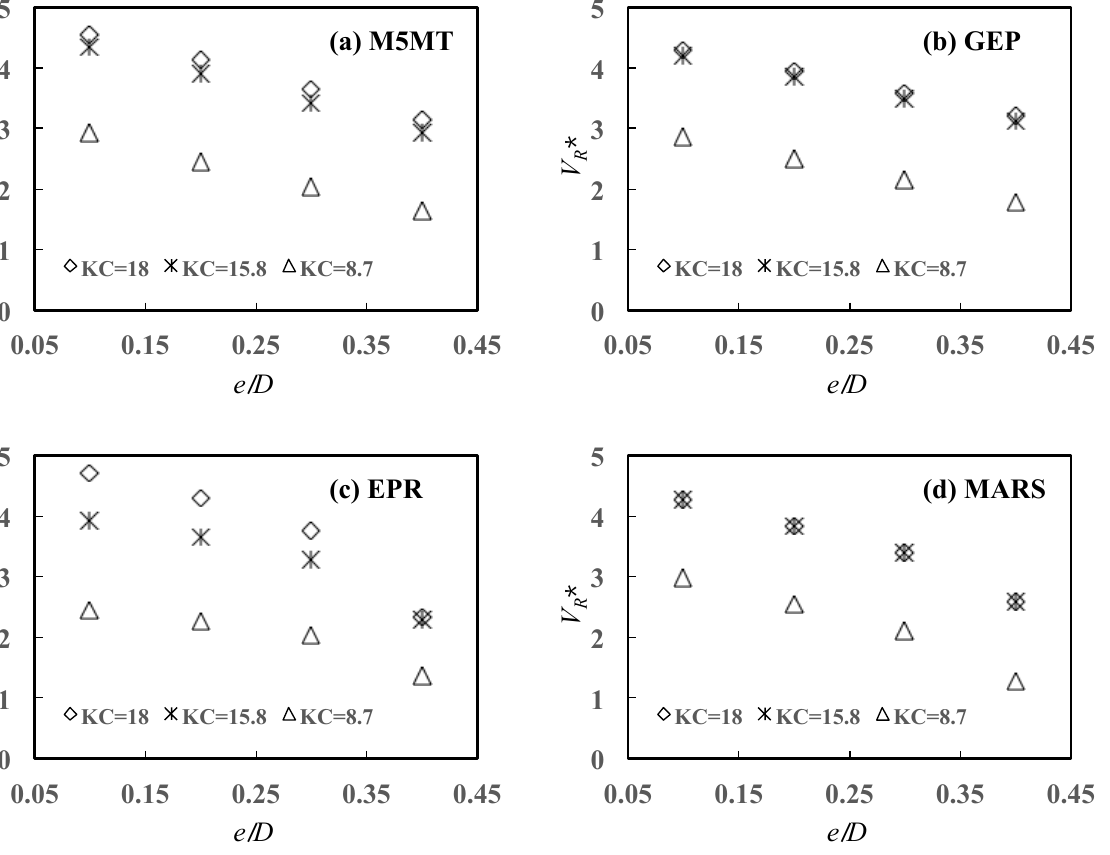
Figure 9. Variations of 𝑉 𝑅∗ against 𝑒 𝐷⁄ at KC from 8.7 to 18.0 and α = 0° for: ( a ) M5MT, ( b ) GEP, ( c ) EPR, and ( d ) MARS.